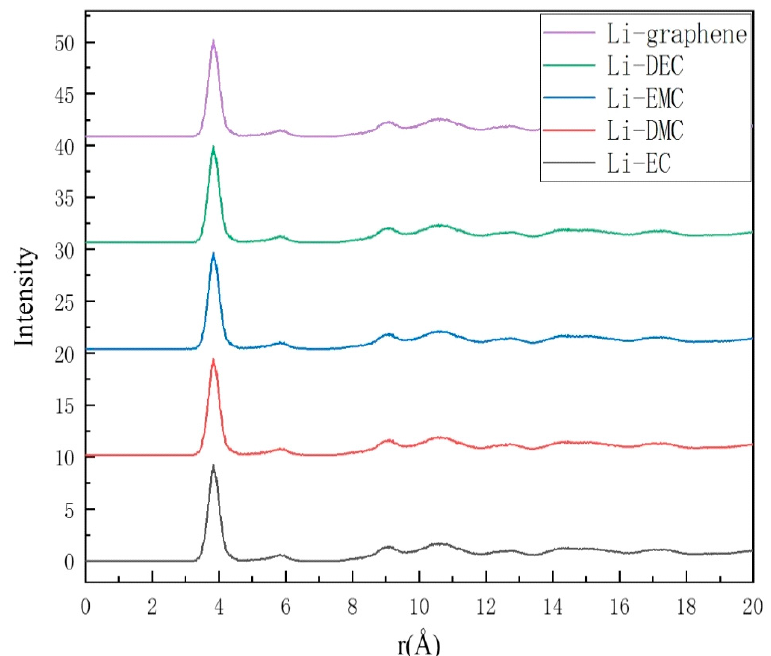
Figure 8. Radial distribution functions (RDFs) of Li ions and carbonate electrolytes in the GNS system.